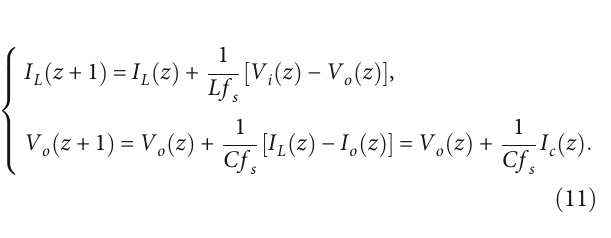
Figure 19: Nonlinear load experimental